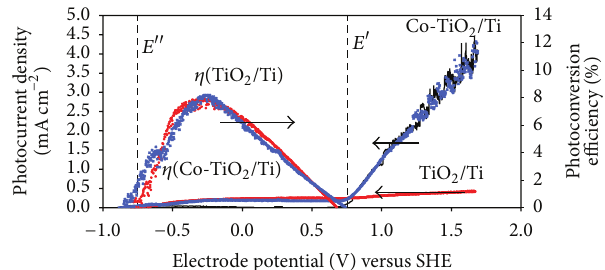
Figure 6: UV photocurrent density and efficiency versus voltage for TiO 2 /Ti ( ∘ ) and Co-TiO 2 /Ti in UV ( × ) and in dark ( — ).